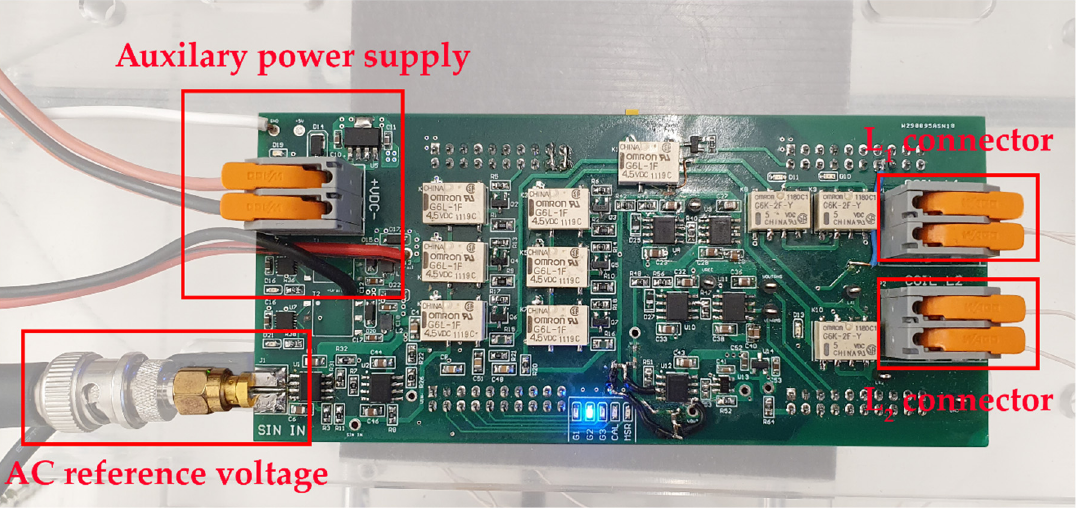
Figure 4. Circuit of the auto-balancing bridge with variable gain.